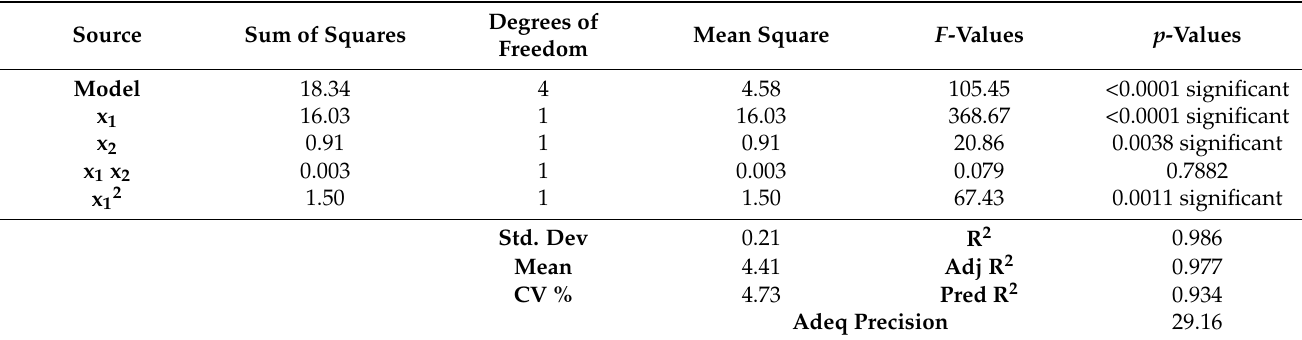
Table 3. ANOVA analysis for the response surface quadratic model in relation to disinfection